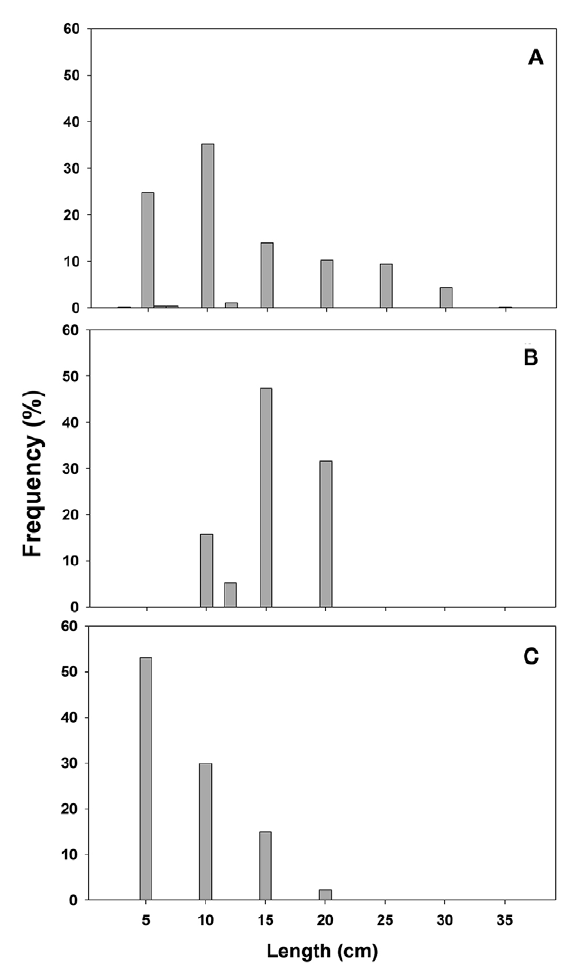
Fig. 4. – Size frequency distribution of the total length of colonies on (A) rocky reefs, (B) rhodolith seabeds and (C) seagrass meadows after the arrival